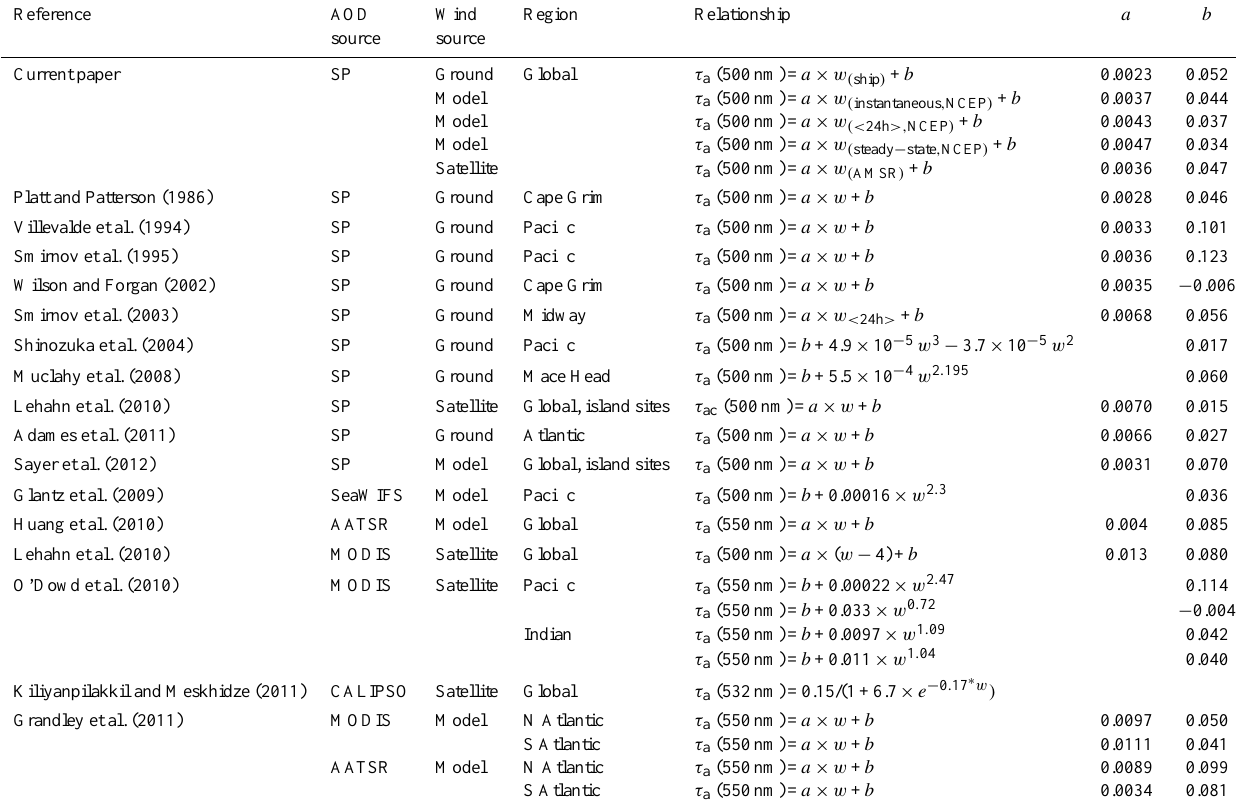
Table 3. Regression statistics of aerosol optical depth versus wind